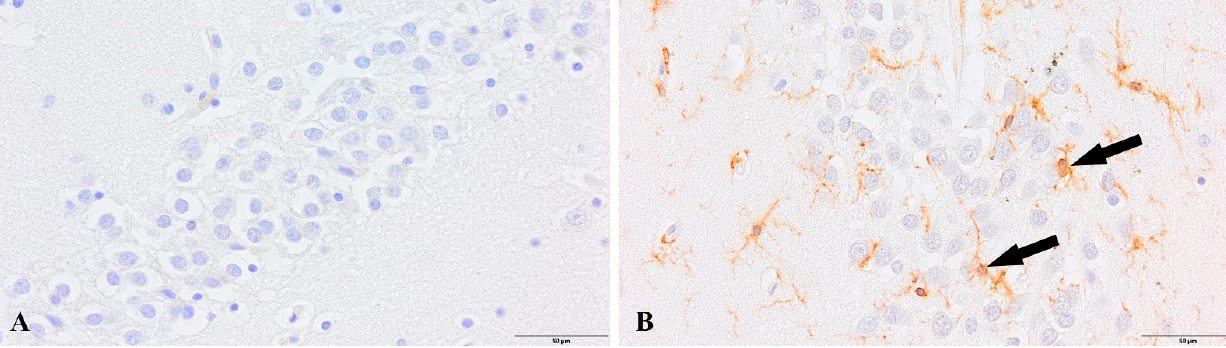
Figure 7. Dentate gyrus. ( A ). Control group. ( B ). Active ramified microglia (arrows). Group patients with diagnosed COVID-19. Immunolabeling LCA antibody.